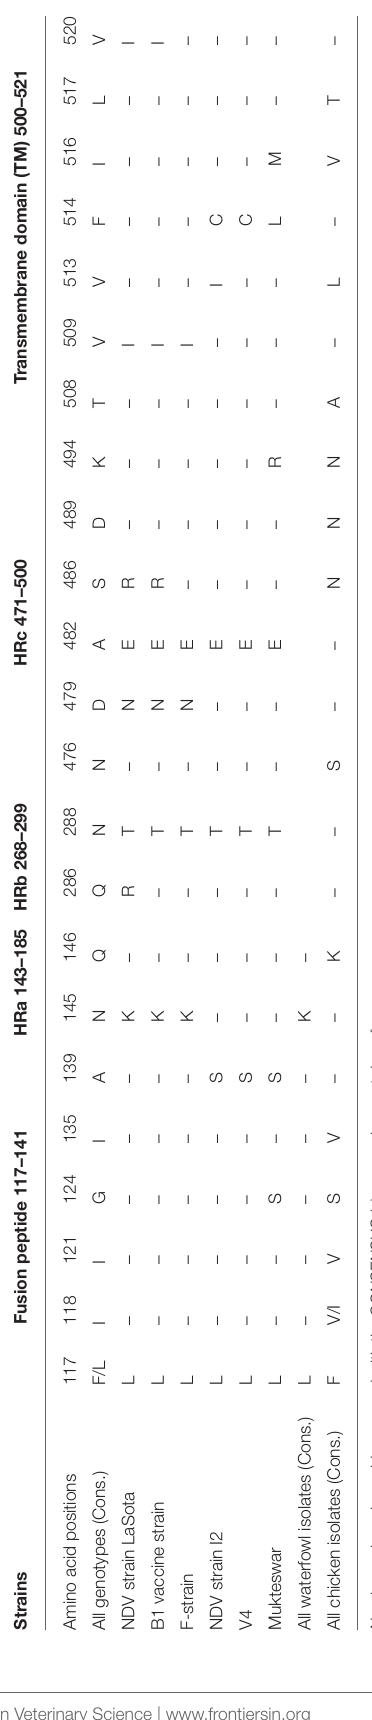
model and perform entropy calculations, we used Scop3D and Chimeras for sequence manipulations and final visualization was done in Discovery Studio Visualize v20.1.0. We confirmed that the seven residues involved in virus neutralization from a stretch of 157–171 and individual residues D72, E74, A75, K78, A79, and L343 were conserved across all poultry virus isolates compared to LaSota. Two AAvV-1 isolates from waterfowl; NDV/WF/MU131/LUT and NDV/WF/MU159/MUS showed 13 amino acids variability at a stretch of 157–171 site with a shift from more hydrophobic to hydrophilic amino acid residues